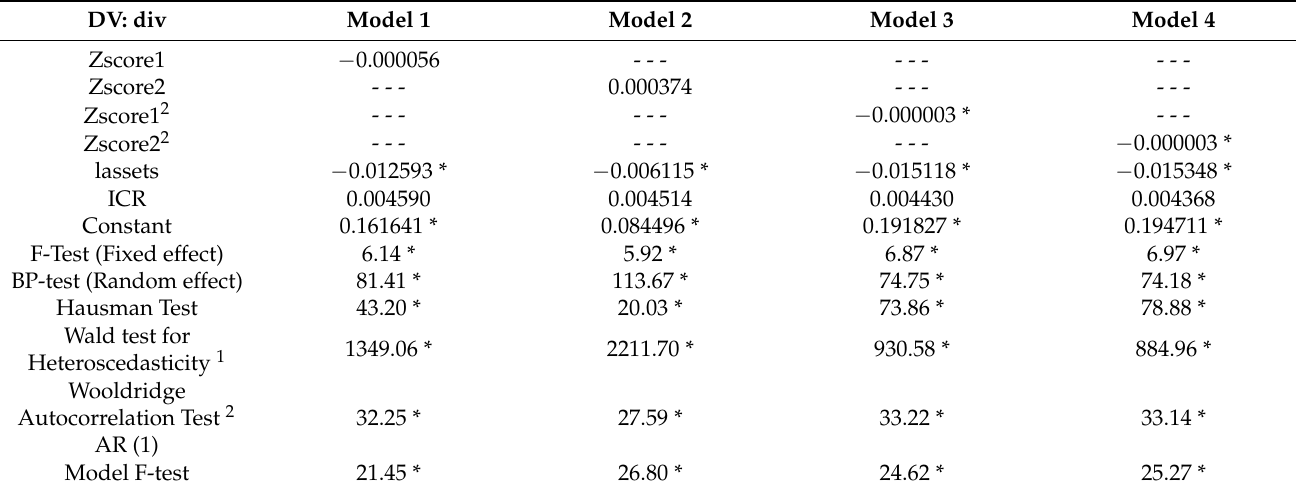
Table 4. Base and Quadratic Models Results (Static Panel Data